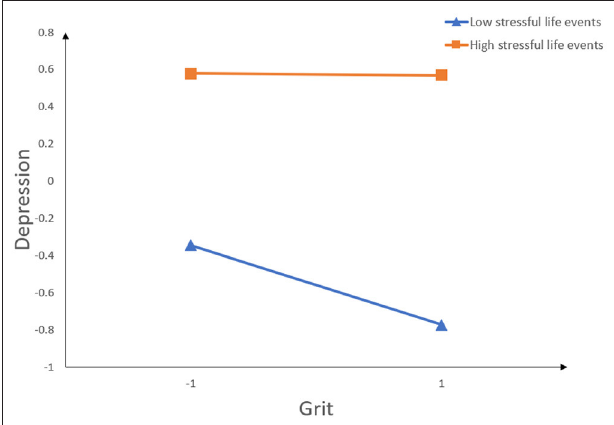
FIGURE 2 | Interaction between grit and stressful life events on